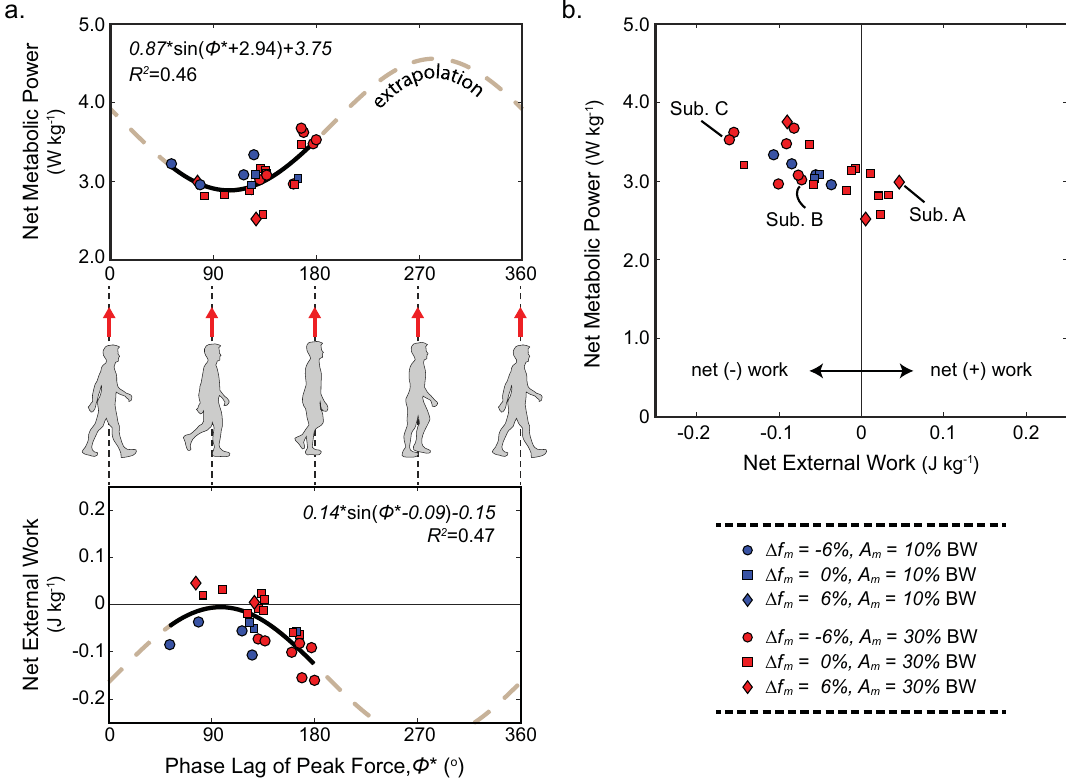
Figure 8. Positive mechanical work from the oscillator decreases metabolic power. Average data are shown for all trials where at least 2 min of consistent entrainment occurred (N = 27) during the time when the metronome was inactive. ( a ) Net metabolic power is plotted versus the phase lag of peak upward force from the oscillations. A phase lag of 0 o (or 360 o ) corresponds to peak upward force occurring at double stance while a lag of 180 o corresponds to peak upward force occurring at midstance (i.e. when the center of mass passes over the stance foot). Net external work done on subjects by the oscillation forces is also plotted versus the phase lag of peak upward force. Arbitrary sinusoidal functions are fit to these data assuming a cyclical relationship between center-of-mass motion and oscillation forces. ( b ) Net metabolic power decreases as a function of net mechanical work done on subjects by the oscillation forces. A linear mixed model was used to assess the effect of net work on metabolic power (both variables non-dimensionalized; see results in Table S1 in the Supplementary Materials). Example data points from subjects A, B and C are labelled for comparison in plots of Fig. 7. Blue and red data points correspond to trial conditions where A m = 10, 30% BW respectively. Circles, squares and diamonds correspond to trial conditions where (cid:31) f m = − 6, 0, 6%